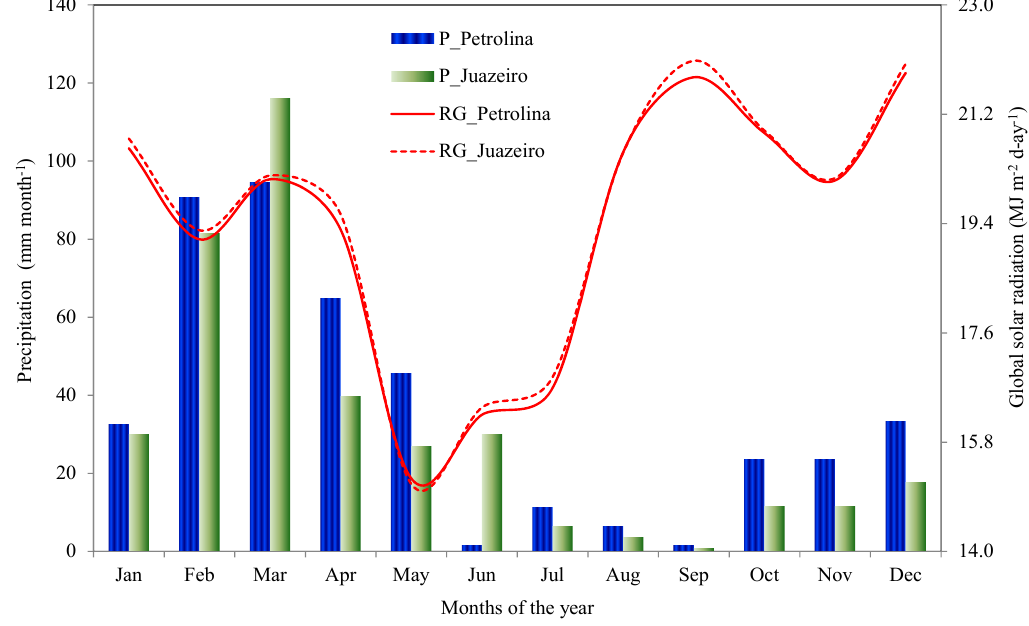
Figure 2. Monthly average daily values of incident global solar radiation (RG) and monthly totals of precipitation (P), at Petrolina (Pernambuco State—PE) and Juazeiro (Bahia State—BA), Brazil, during the year of